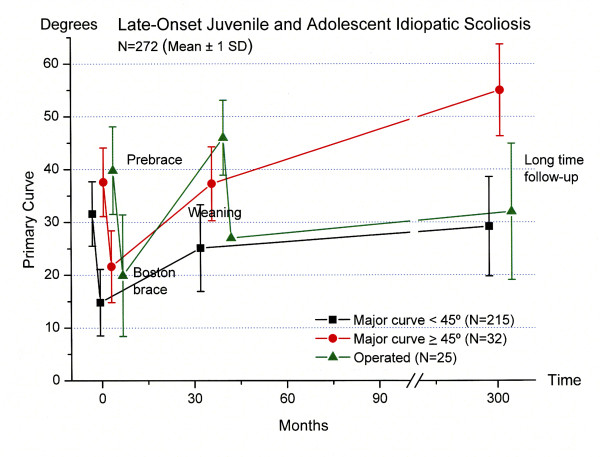
Longitudinal development of the major curve in late-onset juvenile (N = 58) and adolescent idiopathic scoliosis (N = 214). Mean Cobb angle ± 1 SD prebrace, at brace weaning, and at long-term follow-up in 272 patients.